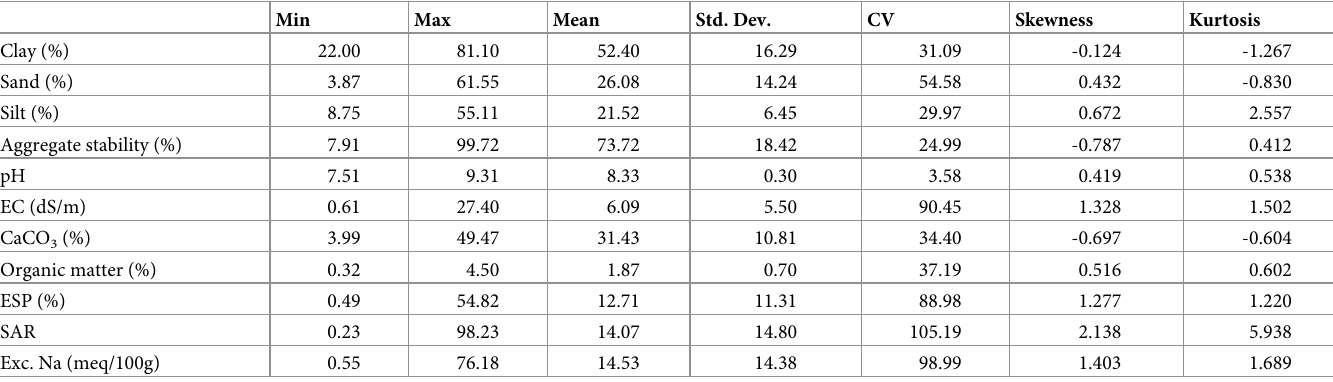
Table 4. Descriptive statistics of surface soils (0–30 cm) in the study area